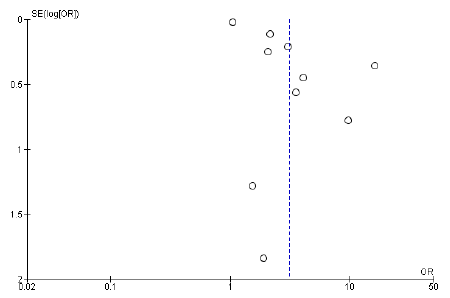
Figure 7. Funnel plot of studies on association between QSC and depression. Note: dot represents individual studies; blue dotted line represents the overall effect.